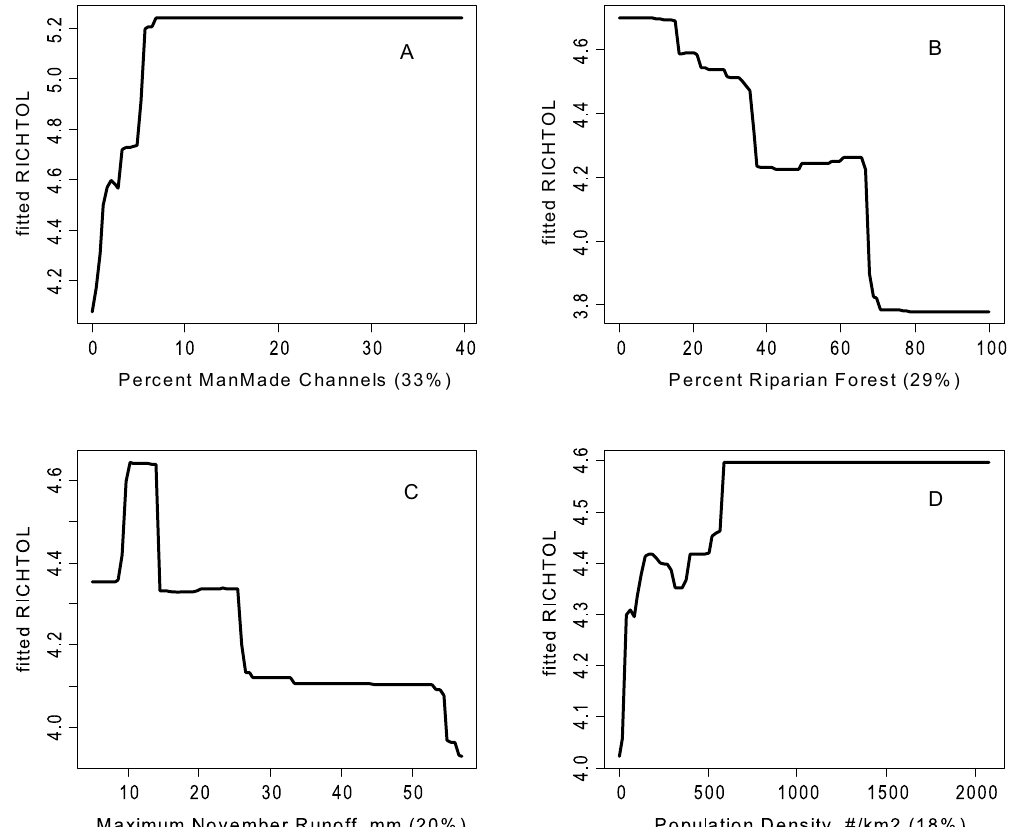
Figure 4. Partial dependency plots for variables in BRT model for RichTOL for Ridge and Valley Region. Boosted regression tree partial dependency plots show the response form of average taxa tolerance (y-axis = fitted function of RichTOL) based on the effect of individual explanatory variables with the response of all other variables removed (development data set). Shown in order of model importance: (A) percent manmade channels, (B) percent riparian forests, (C) maximum November runoff (mm) and (D) population density ( # /km 2 ), model R 2 =0.81. The relative contribution of each explanatory variable is reported in parentheses. Refer to Table 1 for variable definitions. Three of the four variables measure the effects of disturbance, two measure the response to urban land use and the other disturbance in the riparian zone due to either agriculture or urbanization. The fourth variable shows the response due to maximum November runoff.